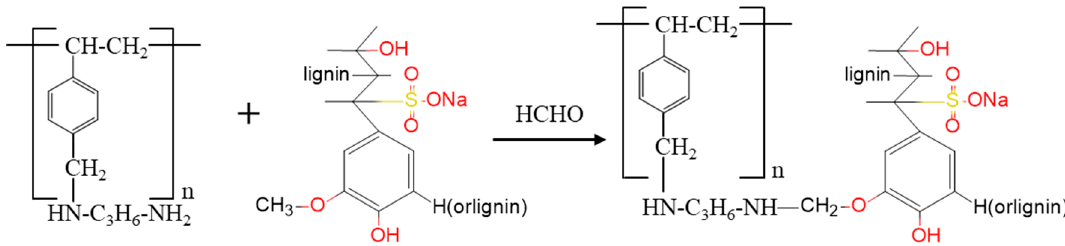
Figure 2. The reaction scheme of sodium lignosulfonate modified polystyrene (SLPS).